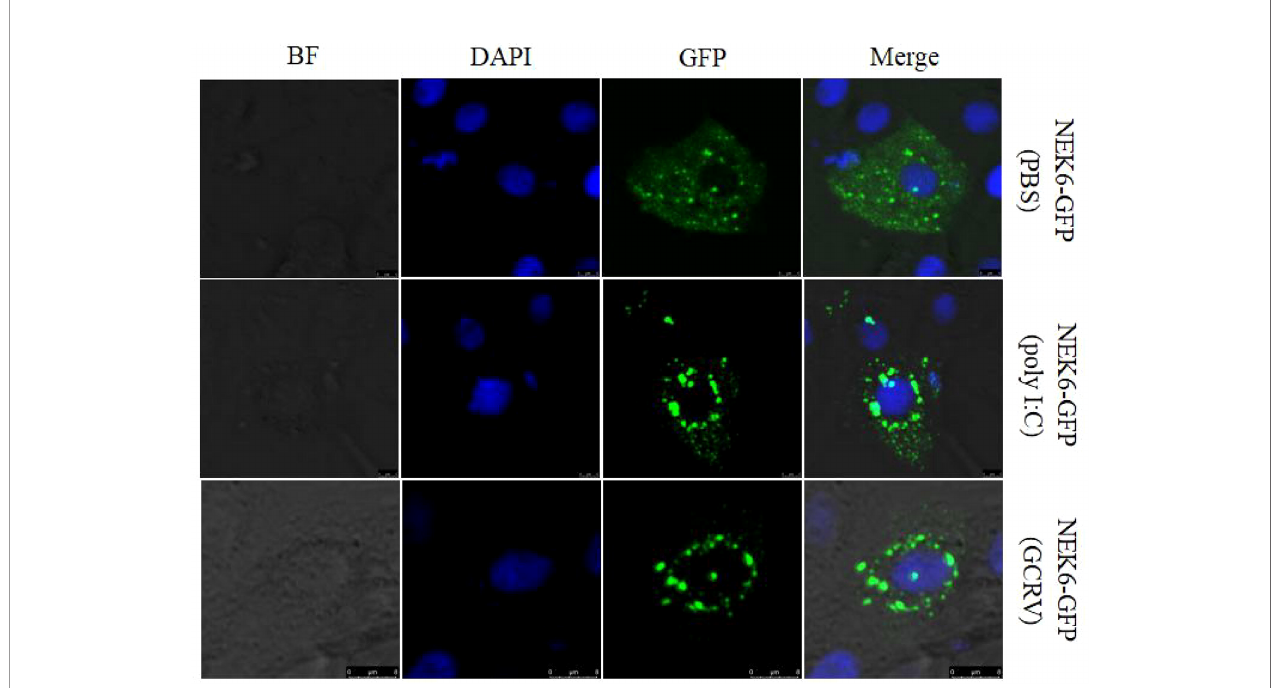
FIGURE 5 | Subcellular localization of CiNEK6 in CIK cells. After CIK cells were transfected with 2 m g of NEK6-GFP plasmids, and the cells were treated with PBS or poly I:C and incubated for another 12 h. Then the cells were washed, fi xed, and dyed. The localization of CiNEK6 in CIK cells were captured by a confocal microscope. The scale bar is 5 µm. Magni fi cation of cells is ×